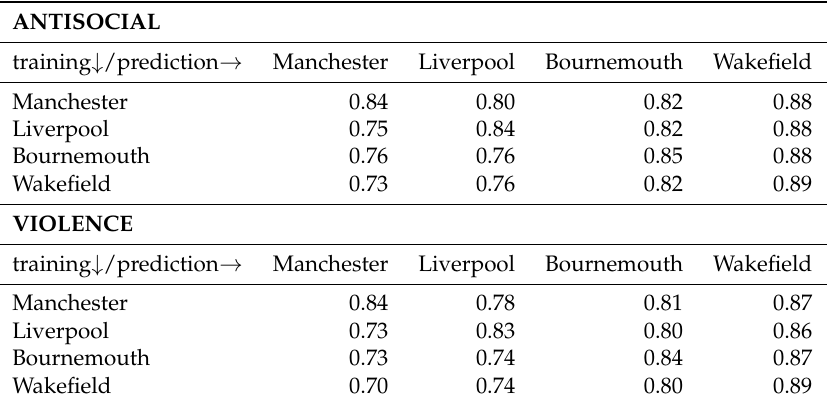
Table 6. AUC values for model